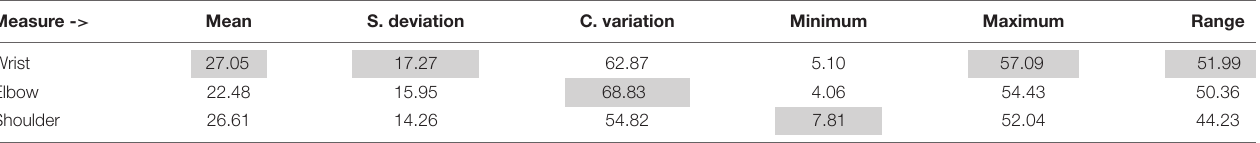
TABLE 3 | Mean descriptive statistics of the dissimilarity measure between successive movement trajectories in virtual scenarios over the trials. Measure -